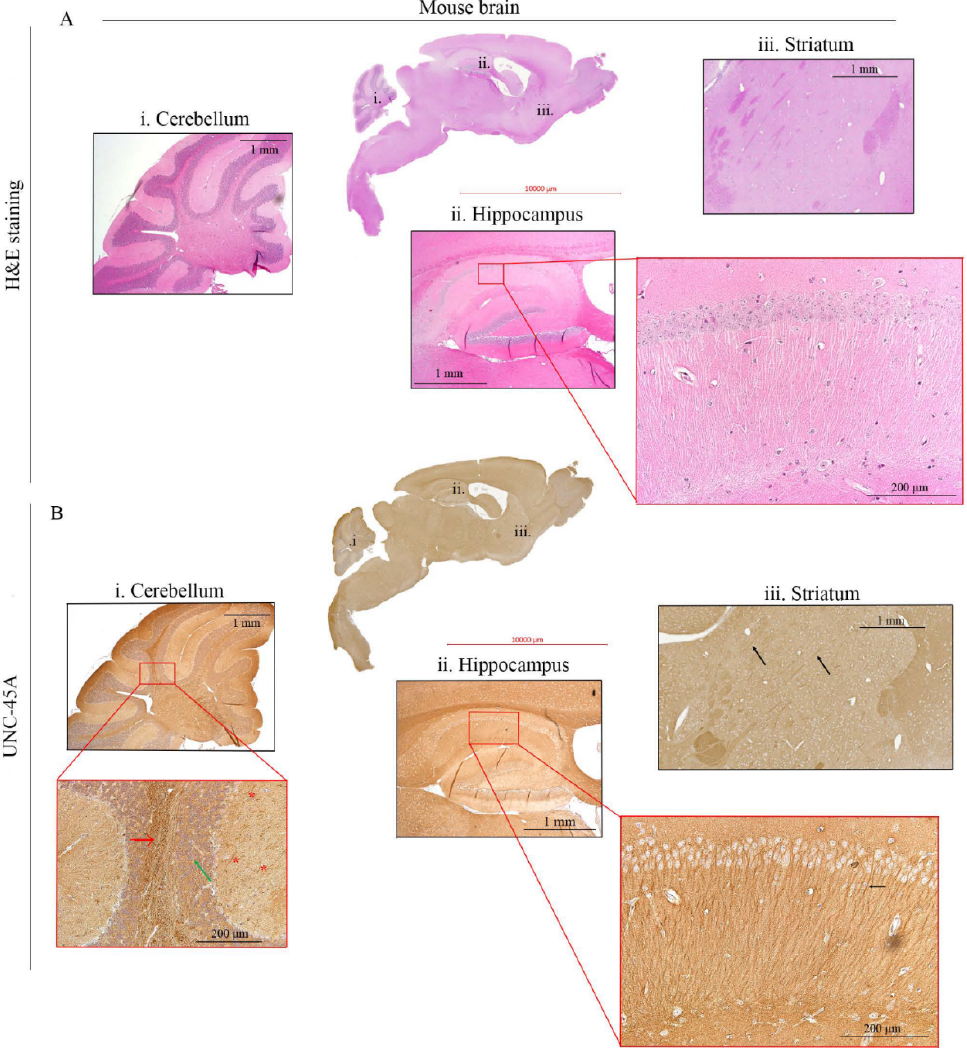
Figure 3. UNC-45A expression in mouse brain via IHC. ( A ) . H&E staining of the whole mouse brain. i. Cerebellum, ii. Hippocampus, iii. Striatum. ( B ) . UNC-45A staining in the whole mouse brain. i. details on UNC-45A staining in Cerebellum (inset) from the center to the sides: white matter (red arrow) granular layer (green arrow), molecular layer (red asterisks), ii. details of UNC-45A staining in hippocampus, inset closer view on hippocampal CA1 neurons, with clearly visible dendrites (black arrow). iii. details of UNC-45A staining in the striatum, arrows indicate stronger UNC-45A staining in nervous